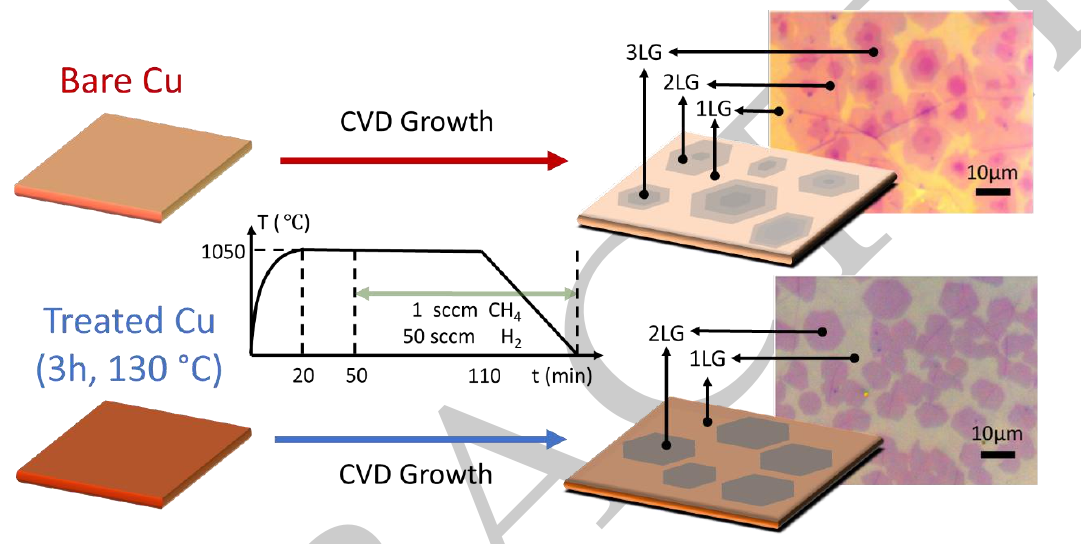
Figure 1. Schematics showing the low-pressure chemical vapor deposition (LPCVD) process for graphene growth on bare and treated Cu substrates. Insets: Optical images of the produced graphene samples transferred on separate SiO 2 / Si substrates, grown using the two di ff erent types of Cu substrates as indicated. 1LG, 2LG, and 3LG represent monolayer, bilayer, and tri-layer graphene, respectively. A 532 nm excitation laser (Ulm, Germany) with a 100 × objective lens (WITec Alpha 300 micro-Raman imaging system) and a laser spot size of ∼ 320 nm was used for the acquisition of all Raman spectra